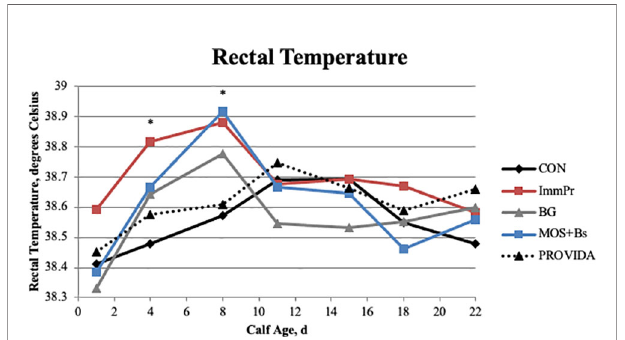
are illustrated in Figure 7 at d 3 ( P =0.071), d 7 ( P =0.043), d 14 ( P =0.065), d 21 ( P =0.054), d 42 ( P =0.061), d 56 ( P =0.003), and d 84